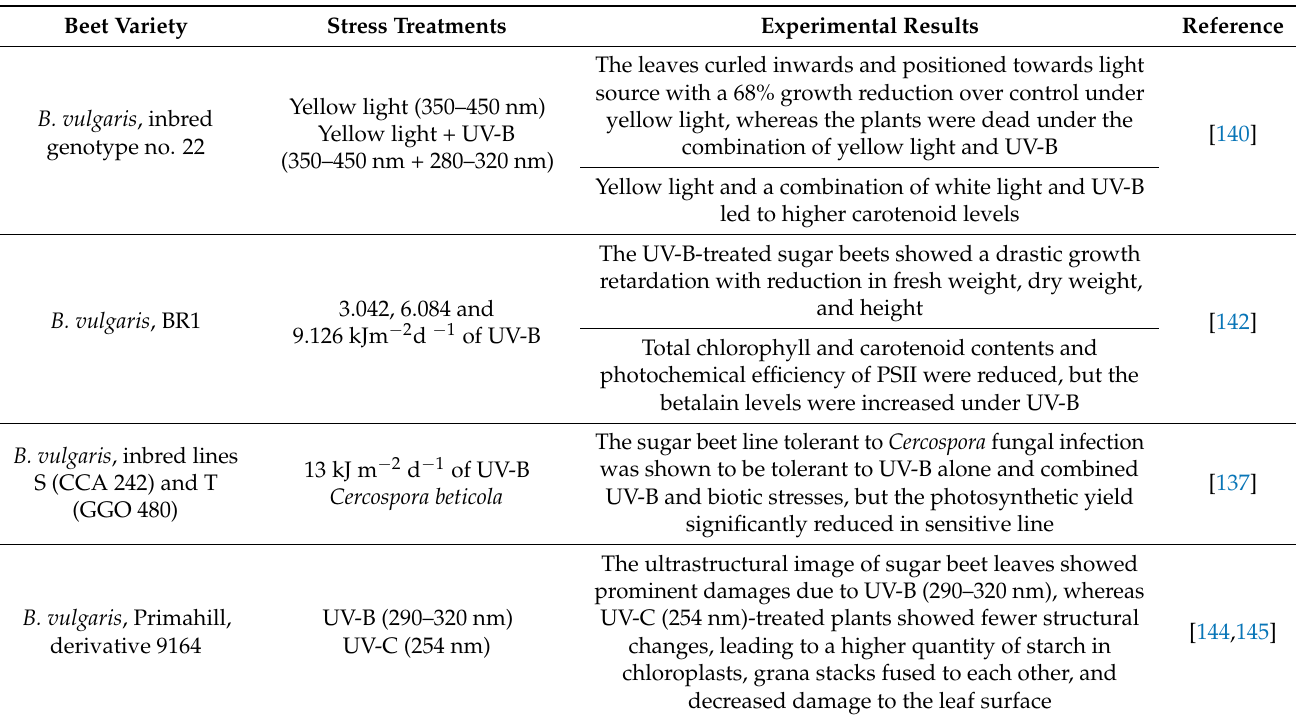
Table 5. UV stress responses in cultivated